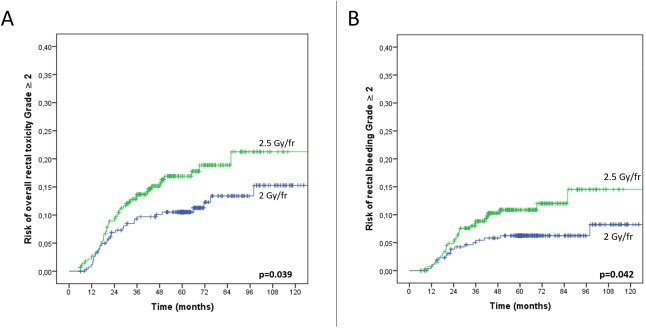
Impact of hypofractionation on the Grade ≥2 overall rectal toxicity (Fig 3A) and rectal bleeding risks (Fig 3B).The patients (n = 555) received a total dose of 70 Gy with the same 3D conformal RT technique, at either 2 Gy/fr (n = 272) or 2.5 Gy/fr (n = 283).